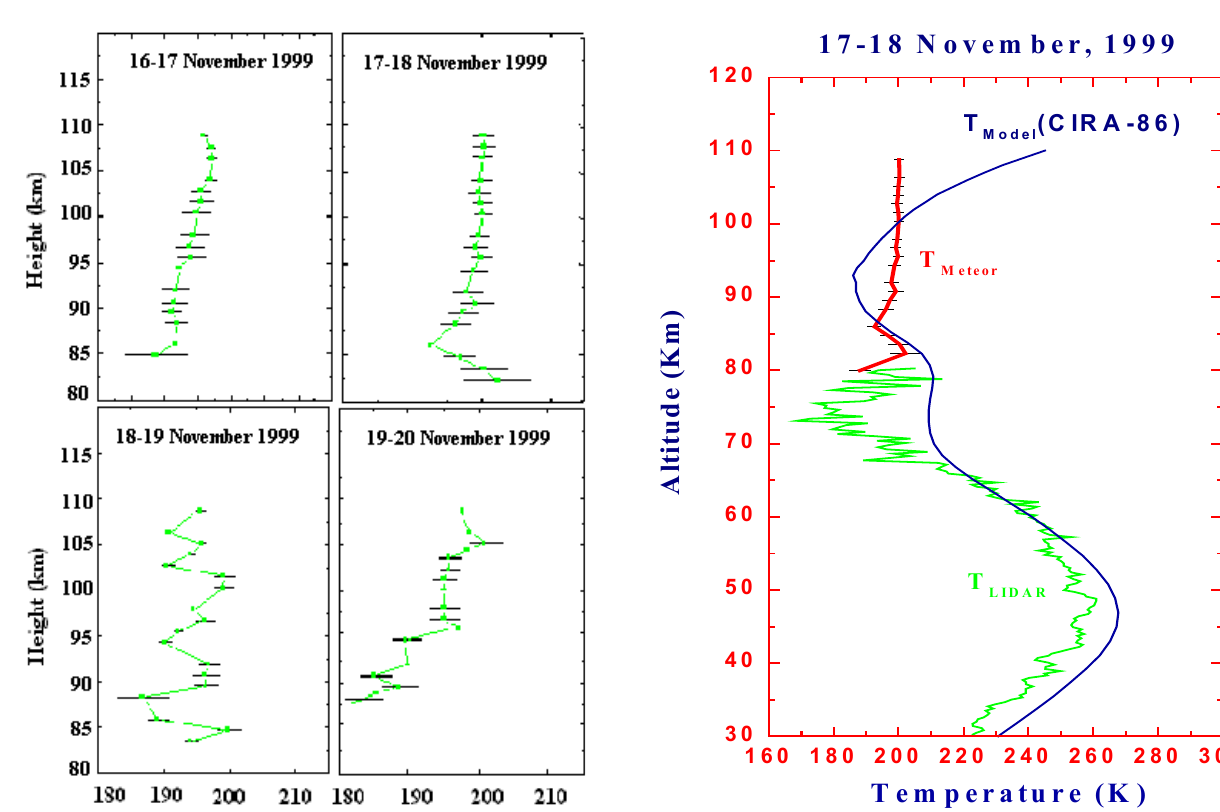
Fig. 7. Temperature profile obtained from meteor trace augmented with the temperature obtained using LIDAR and comparison with the